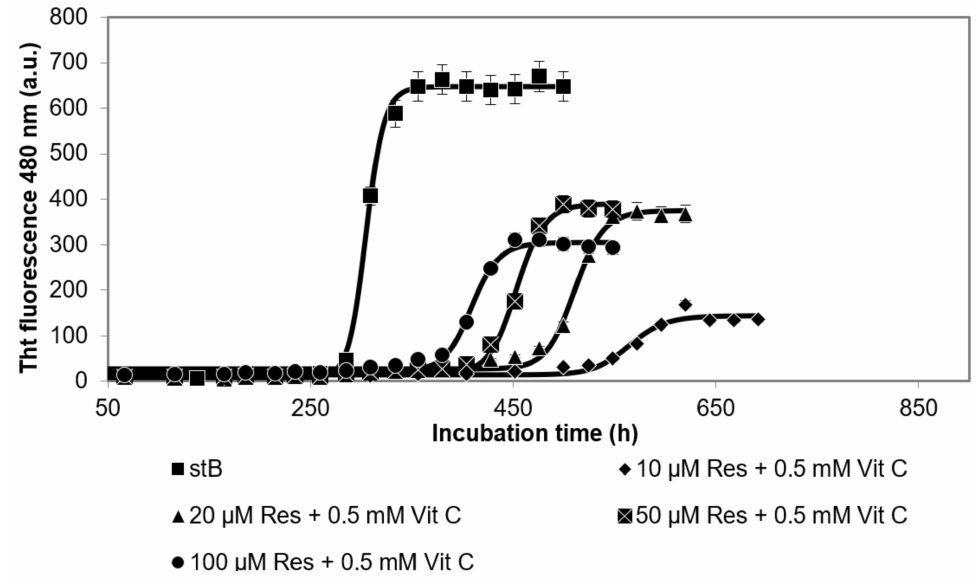
Figure 3. Time course of ThT fluorescence intensity following amyloid fibril formation of stB in the presence of resveratrol (Res). Different concentrations of Res (as indicated) were added, while vitC concentration was kept constant at 0.5 mM.